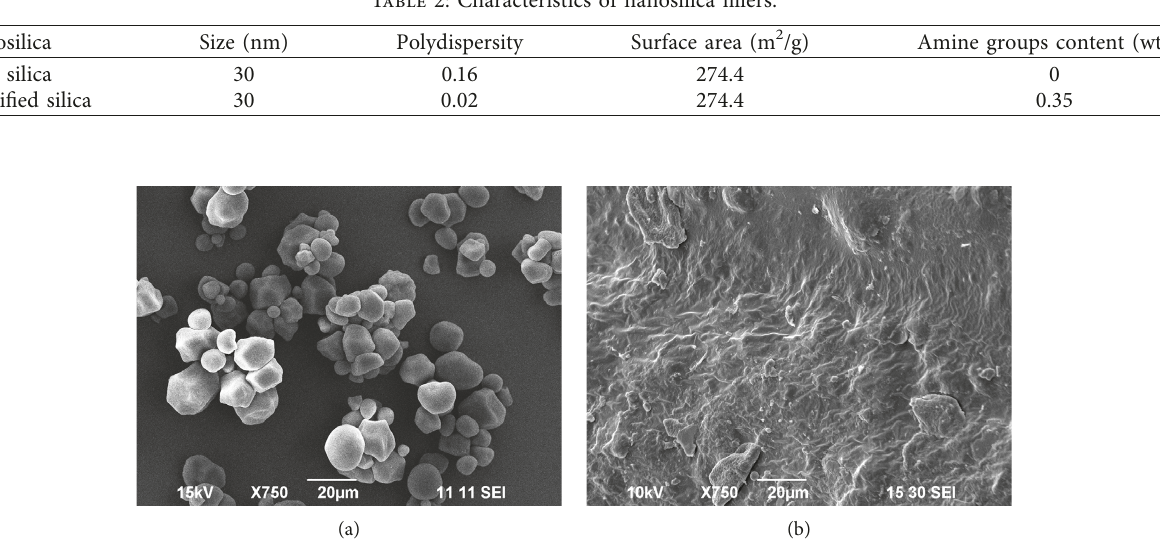
Figure 1: SEM images of (a) native corn starch and (b) thermoplastic corn starch.